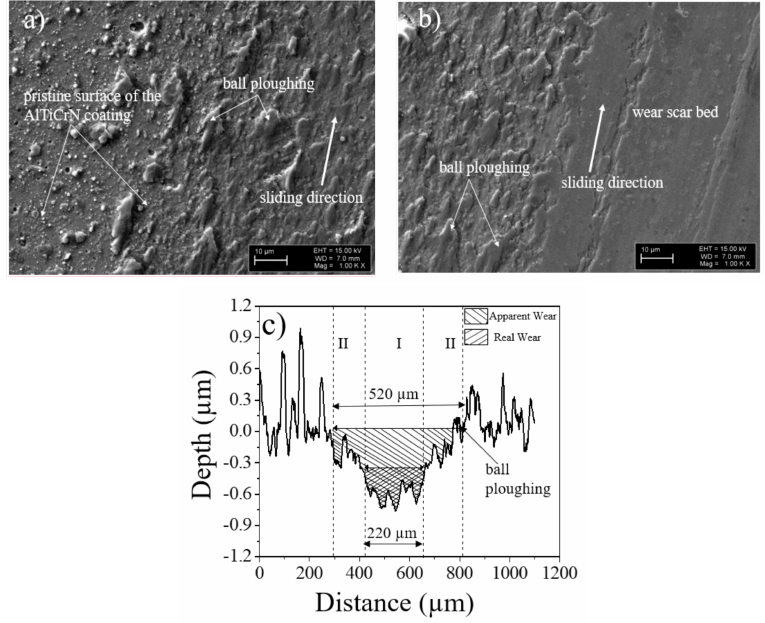
Figure 4. SEM images of the sample tested at 800 ◦ C: ( a ) pristine surface and region II, ( b ) regions II and I (see Figure 3g,h) and ( c ) apparent and real wear